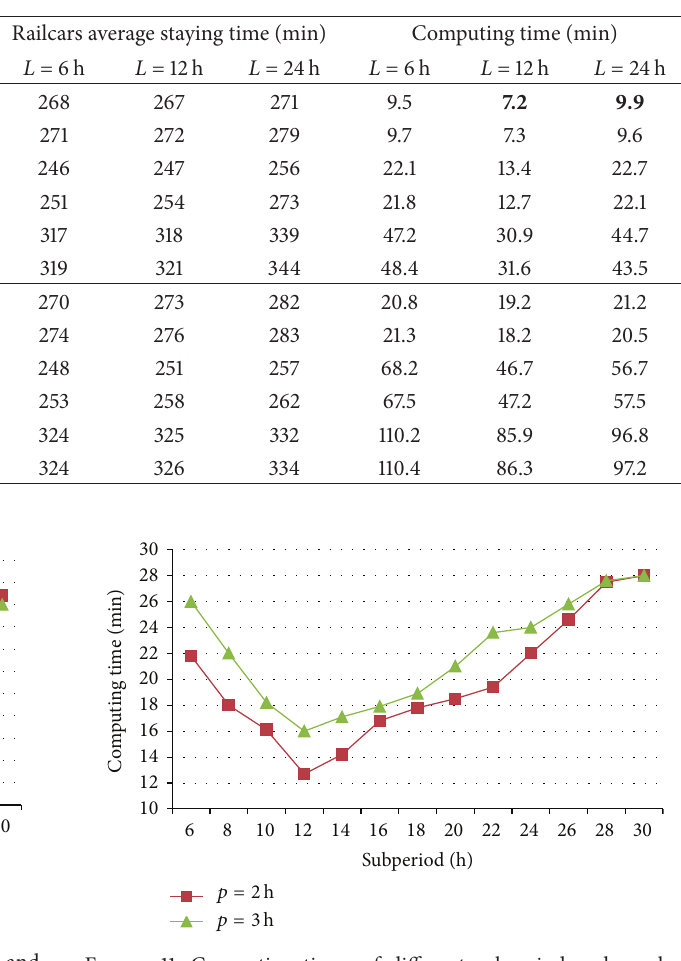
Figure 11: Computing times of different subperiod and overlap